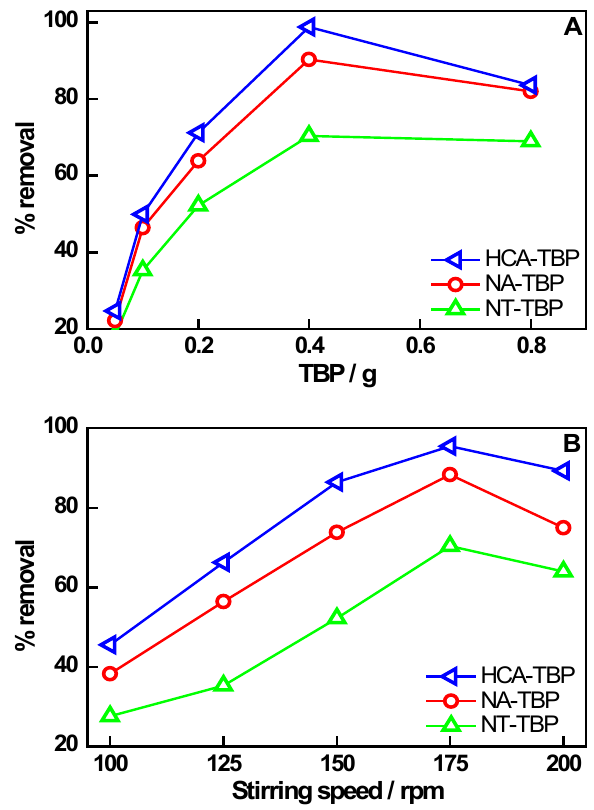
Figure 2: Effect of TBP dose (A) and stirring speed (B) on Pb(II) removal by original and chemically pretreated